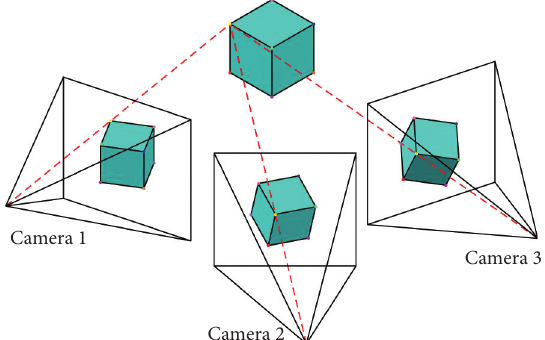
Figure 11: The point cloud extracted after SFM.